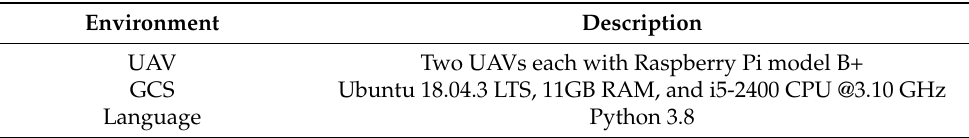
Figure 9. The actual experimental testbed for the proposed security protocol. Table 7. Implementation